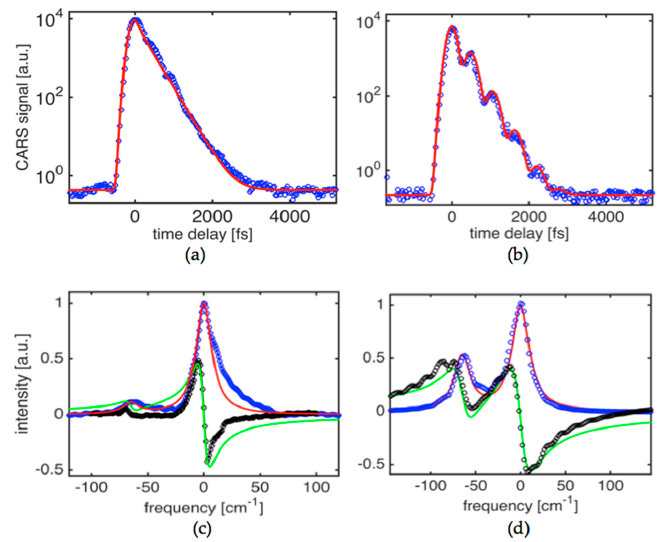
Figure 2. ( a ) Time-domain CARS signal (open circles) obtained from KTP crystal when the OPO wavelengths were set to 1019 nm and 1098 nm (~706 cm − 1 ). The red solid line represents the theoretical fit that assumes single exponential decay for G ( t ) with the dephasing time of 495 fs; ( b ) Time-domain CARS signal (open circles) obtained from KTP crystal when the OPO wavelengths were set to 967 nm and 1041 nm. The solid line represents theoretical fit that assumes a Raman doublet with 62 cm − 1 frequency difference and decaying with the dephasing times of 495 fs and 515 fs; ( c , d ) Corresponding spectra of the resonant third-order nonlinearity obtained with the help of the equation presented in the text. The real part of the third-order susceptibility ( χ (3) ) is shown in black open circles, while the imaginary part is shown in blue circles. Solid lines show the results of simulations for both parts of the nonlinearity, assuming a Lorentzian profile for the two components with parameters outlined in the text.